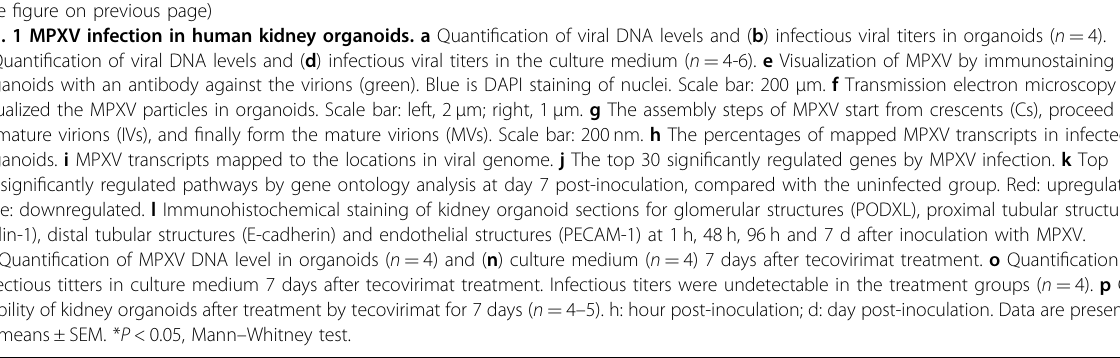
(Fig. 1e). Transmission electron microscopy visualized the intracellular MPXV particles and captured the three successive stages of MPXV assembly in kidney organoids